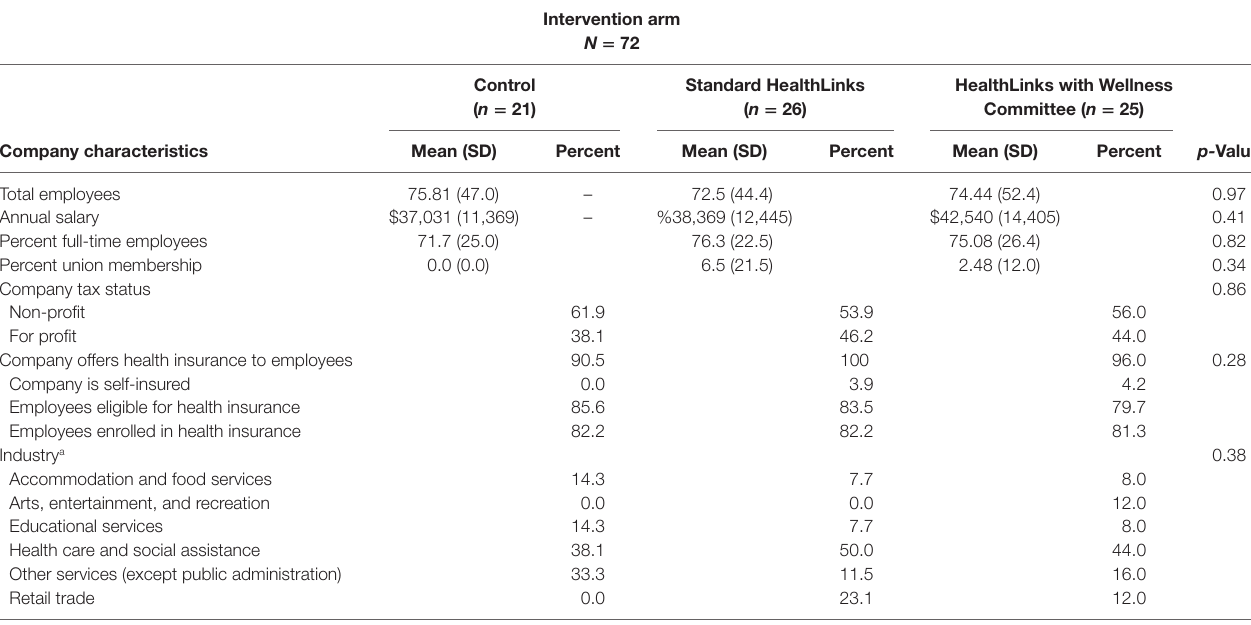
Table 2 | Characteristics of participating companies by study